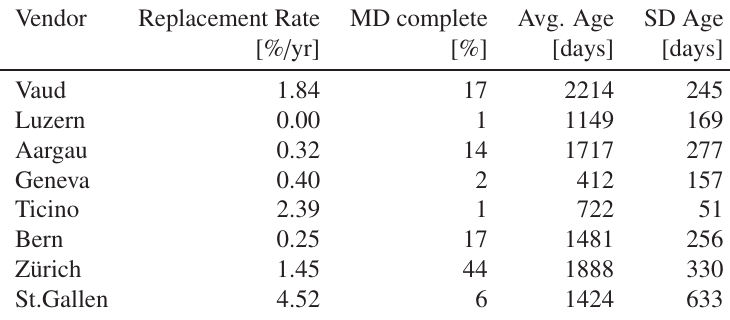
With the above caveat concerning the limited statistics, we include here in table 1 the data for individual models together with the average drive age. Due to the above limitations, we can at this point not significantly confirm an increased failure rate with drive